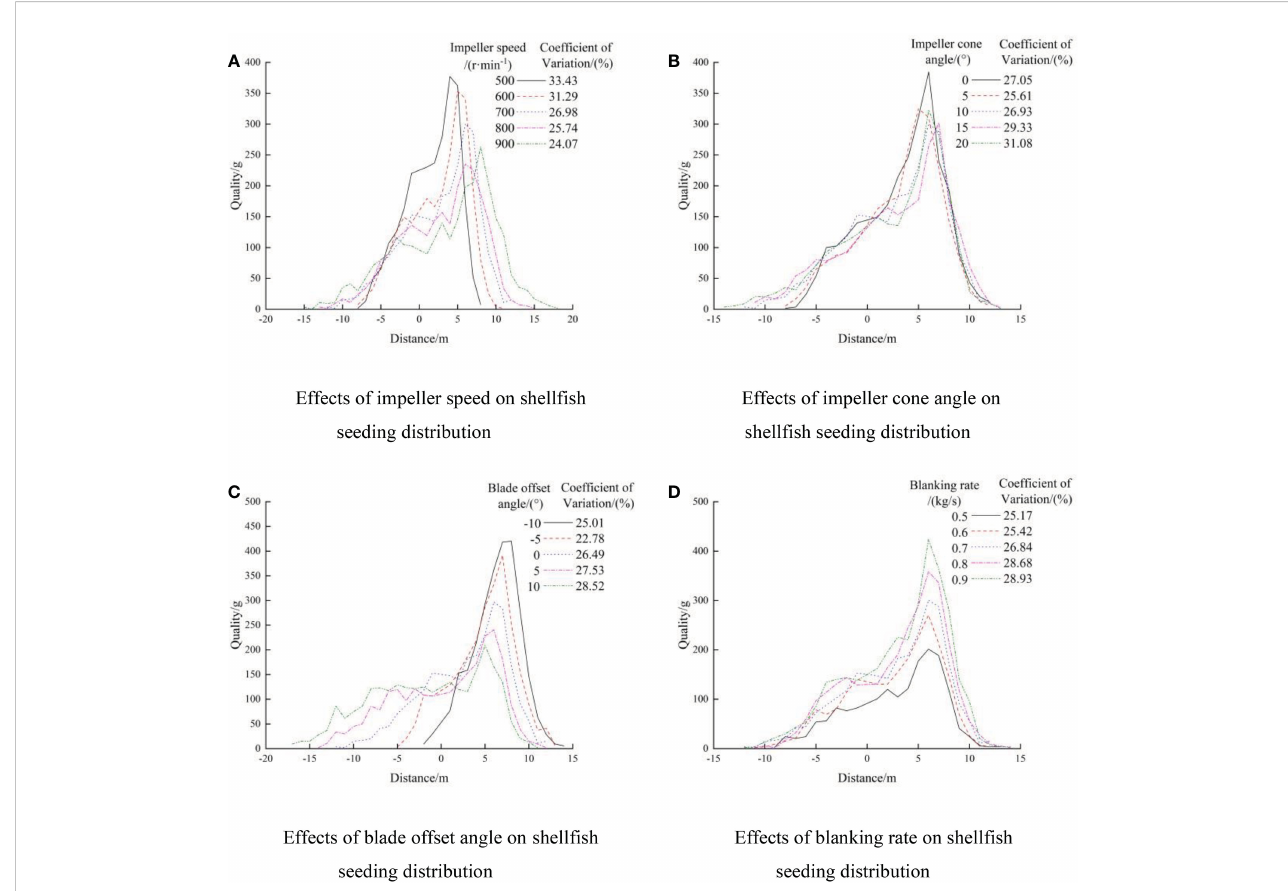
FIGURE 9 Effects of single factor on shell fi sh seeding distribution. (A) Effects of impeller speed on shell fi sh (B) Effects of impeller cone angle on seeding distribution shell fi sh seeding distribution (C) Effects of blade offset angle on shell fi sh (D) Effects of blanking rate on shell fi sh seeding distribution seeding